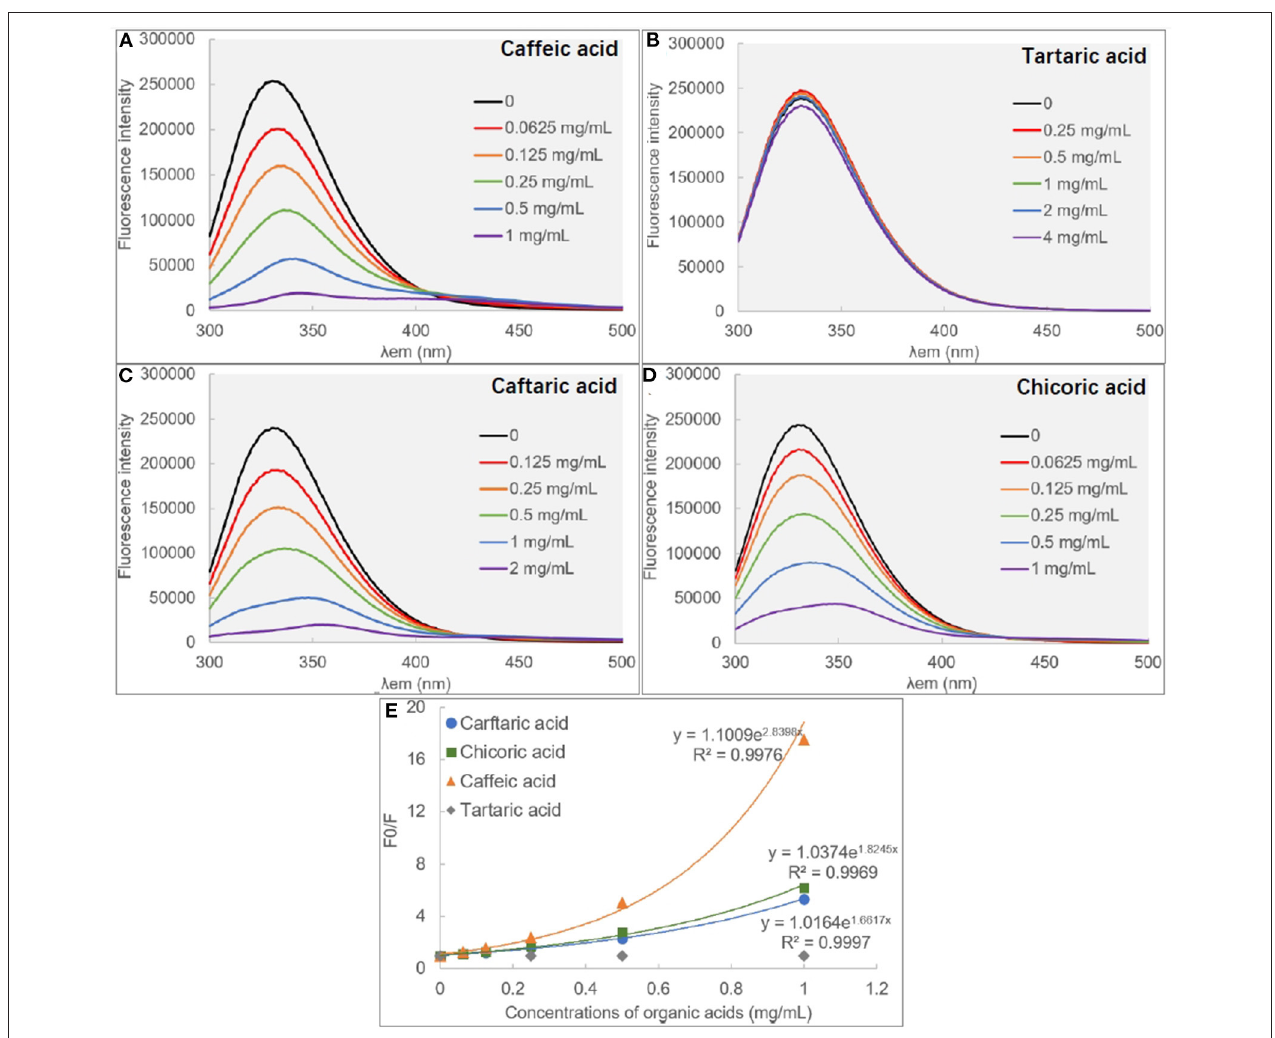
FIGURE 3 | The fluorescence spectra of α -glucosidase in the absence and presence of caffeic acid (A) , tartaric acid (B) , caffeic acid (C) and chicoric acid (D) , respectively, and the modified Stern-Volmer equation (E) was applied for the quenching analysis.